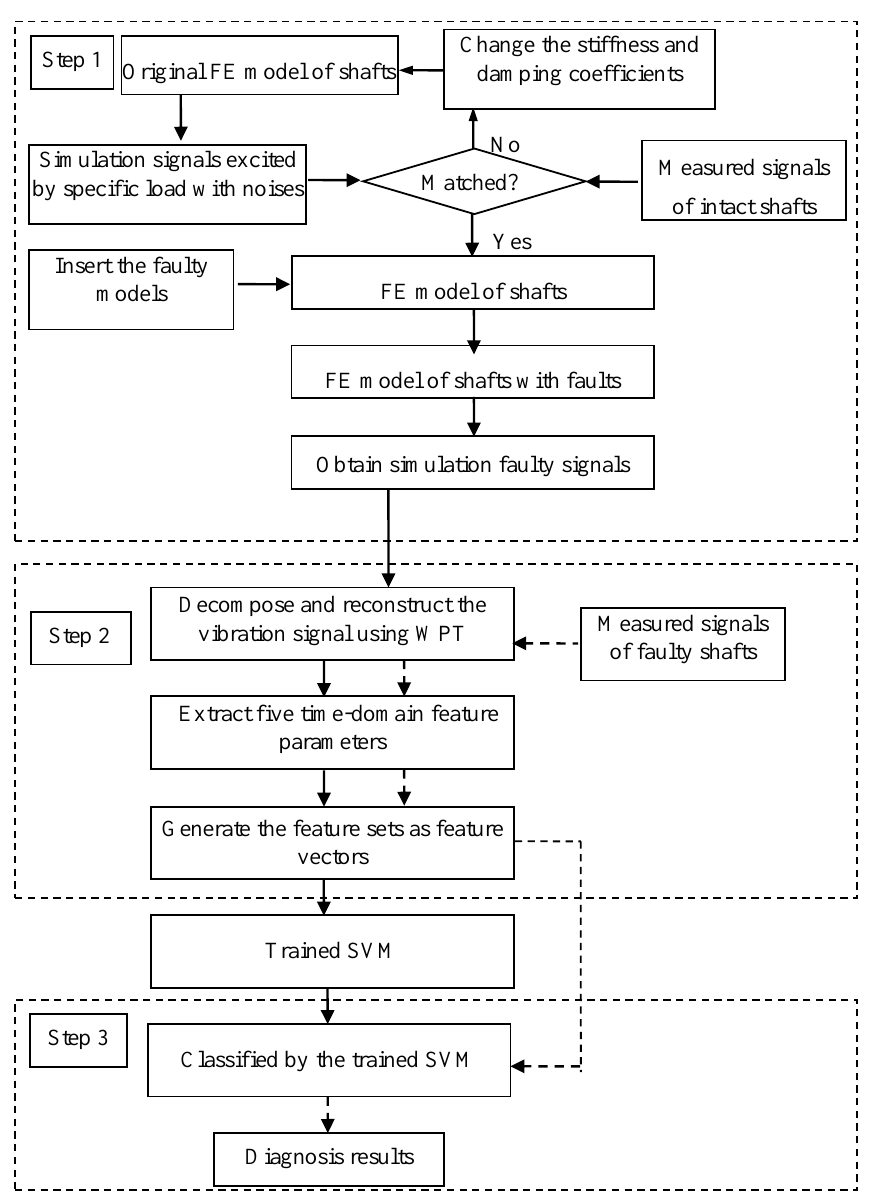
Figure 3. The flowchart of the proposed fault diagnosis method. Solid and dotted arrows mean the training and testing paths to realize the